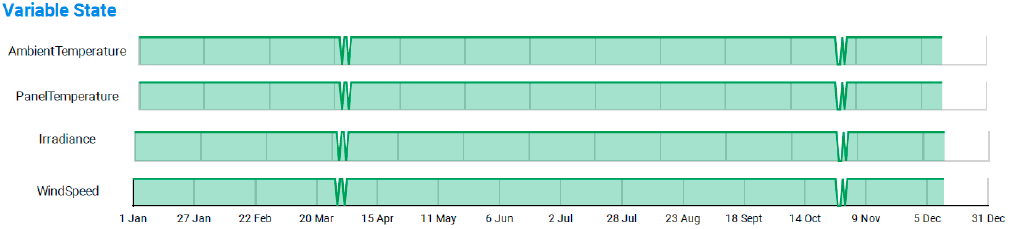
Figure 8. Weather sensor time series over the evaluation period (January–December 2021).